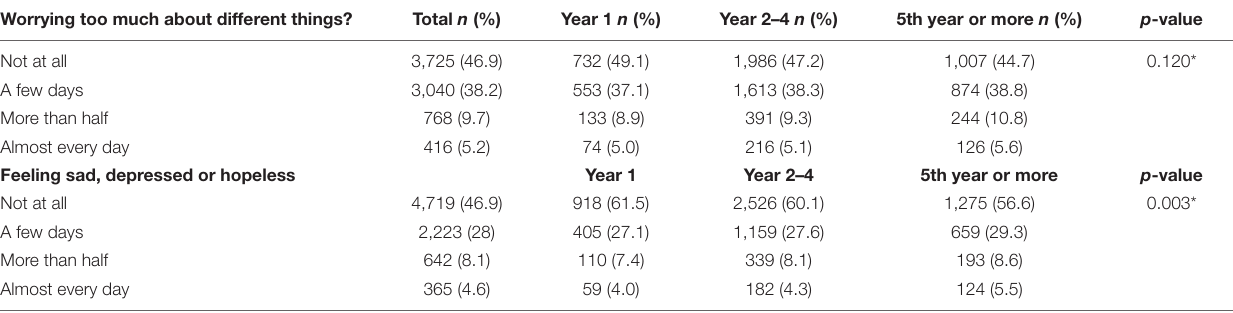
TABLE 8 | Overview of Mental Health during a pandemic by year of